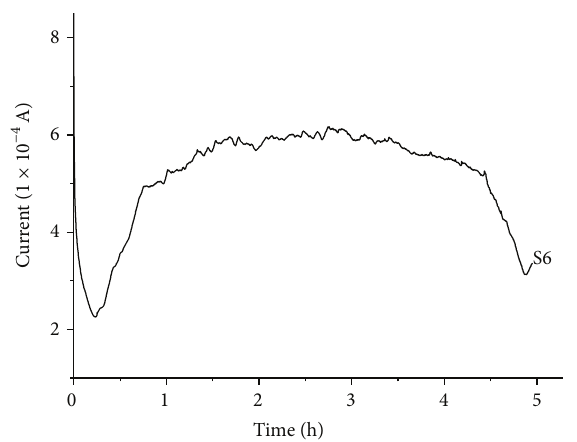
Figure 7: Current-time curve of the spirulina solar cell with sucrose under the light for 4h.